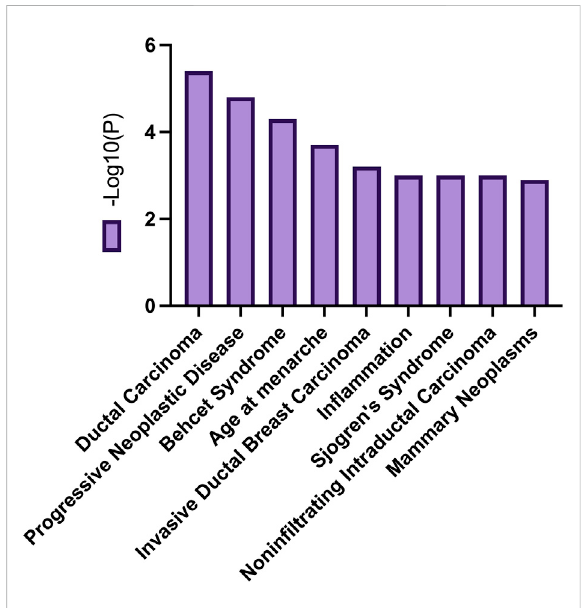
FIGURE 13 Common biological processes related to DEGs overexpressed in young women of the white